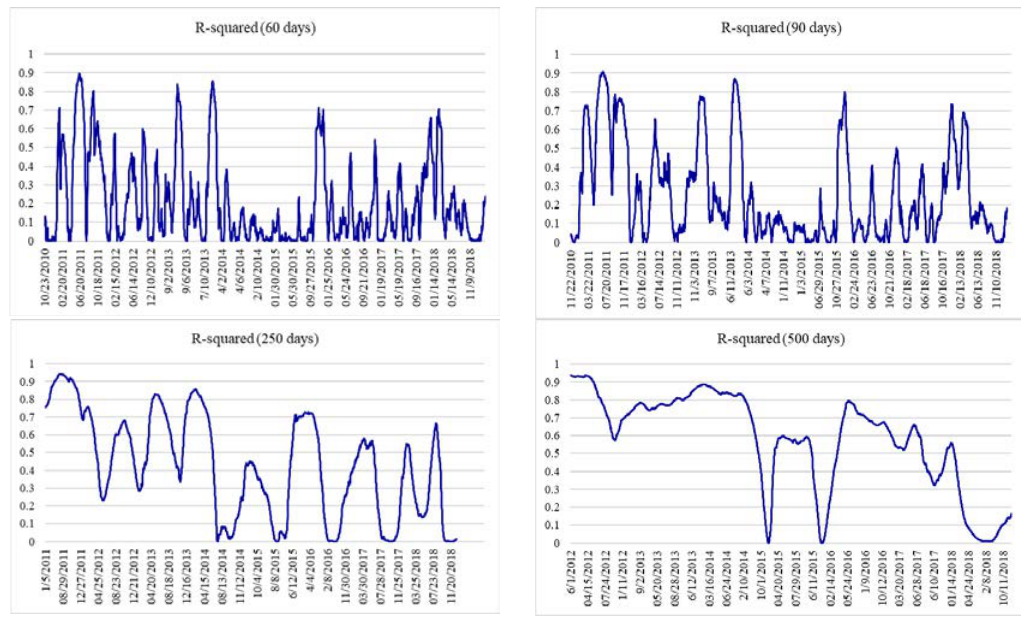
Figure 6 : Adjusted R-squared for Metcalfe’s law (Equation 6), estimated on rolling windows of 60, 90,